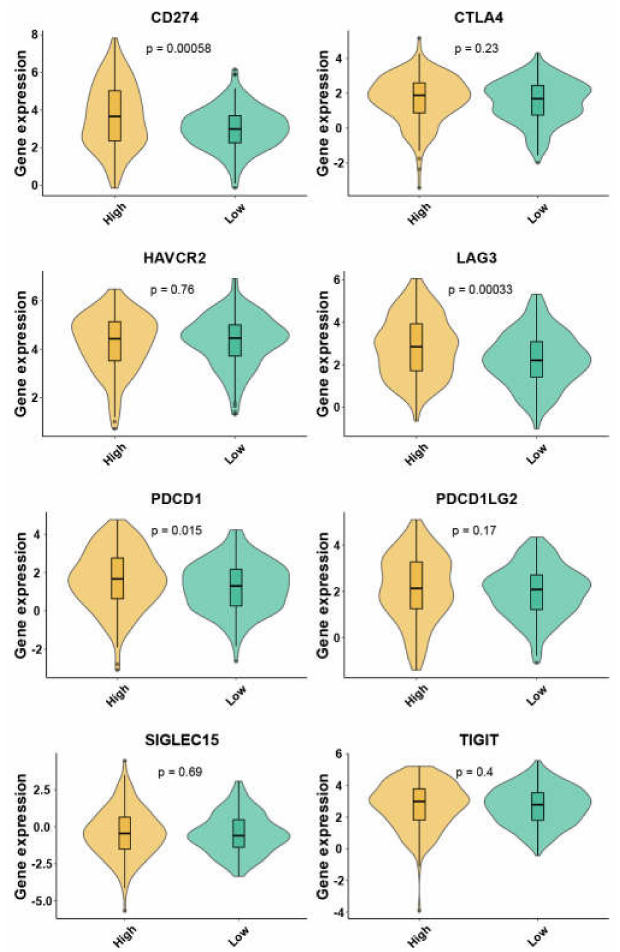
Figure 6. The expression of eight immune checkpoint family genes between two mitophagy groups by violin